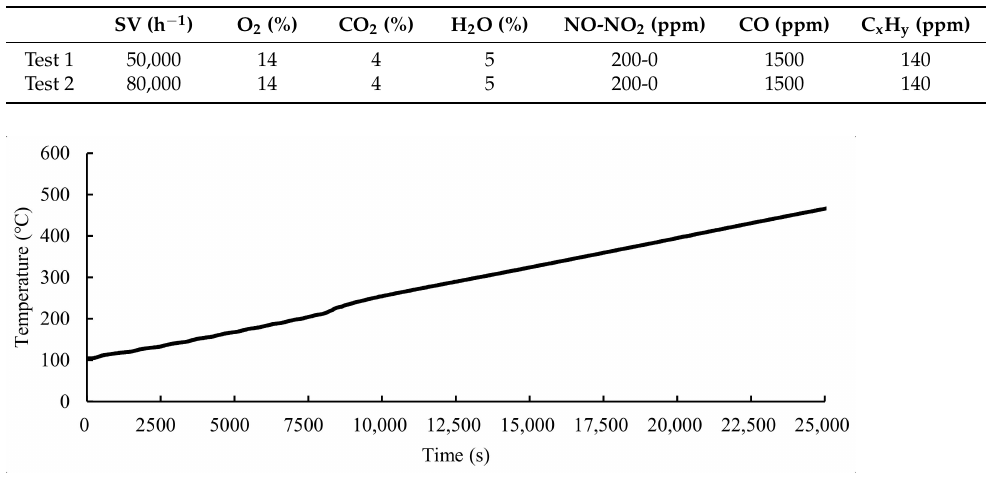
Figure 2. Temperature ramp-up curve.